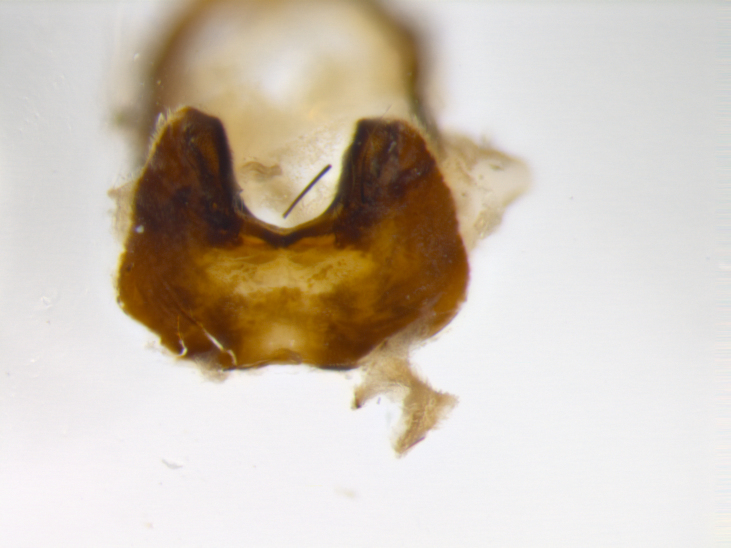
sternite 5, ventral view